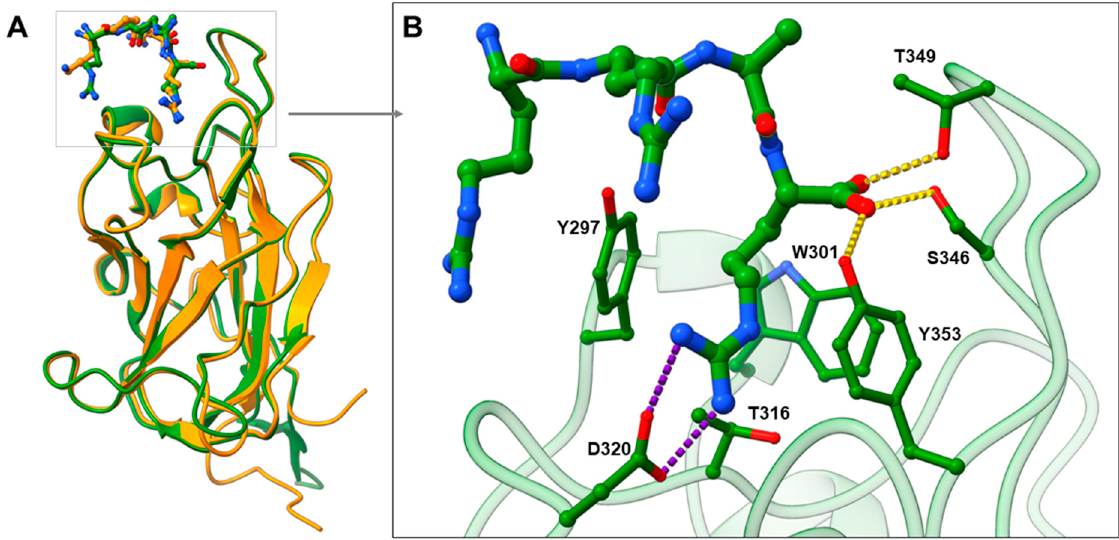
Figure 1. ( A ) Comparison of the binding modes of VEGF ‐ A 164 (in orange stick representation) and SARS ‐ CoV ‐ 2 (in green stick representation) CendR motifs by superimposing VEGF ‐ A ‐ NRP1 (PDB ID: 4DEQ; [17] NRP1 in orange cartoon representation) and SARS ‐ CoV ‐ 2 ‐ NRP1 (PDB ID: 7JJC; [6] NRP1 in green cartoon representation) complexes. ( B ) Zoomed view representing SARS ‐ CoV ‐ 2 CendR binding mode into the b1 domain of NRP1, highlighting interactions with the key amino ‐ acid residues (in green stick representation). Hydrogen bonding and salt bridge interactions are depicted as yellow and violet dashes, respectively.